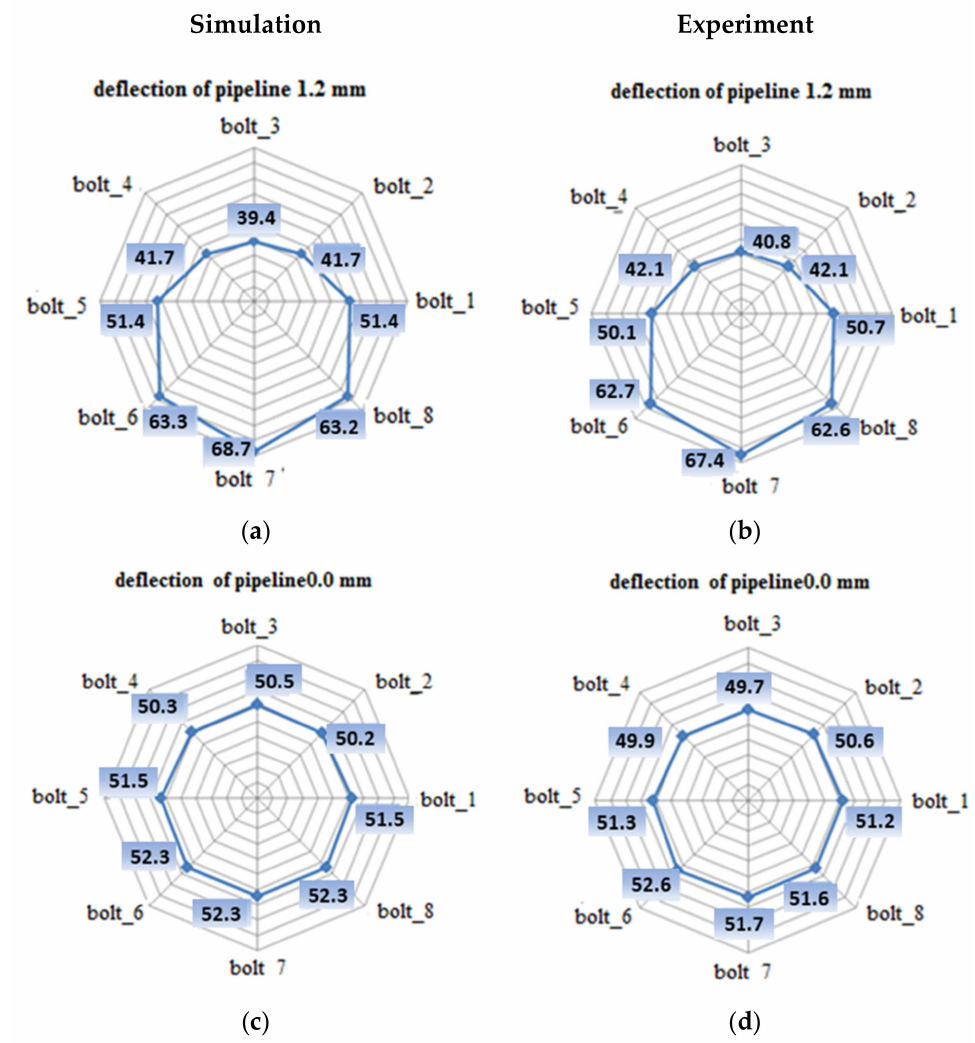
Figure 23. The distribution of the tension in the bolts in the real joint and the calculation model: ( a ) the distribution of bolt tension in the calculation model due to 1.2 mm deflection; ( b ) the distribution of bolt tension in the real joint due to 1.2 mm deflection; ( c ) the distribution of bolt tension in the calcu- lation model before deflection; ( d ) the distribution of bolt tension in the real joint before